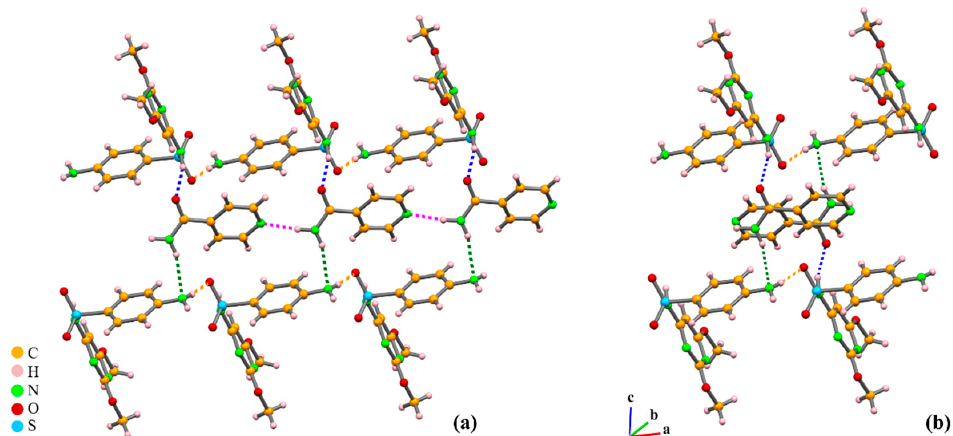
Figure 8. Crystal packing of SDM:ISO cocrystal: ( a ) in a view along the b-axis, with linear SDM chains interacting with two antiparallel ISO chains; ( b ) detail depicting the N − H terminal amine (SDM) ··· O sulfone (SDM) (yellow), N − H sulfonamide (SDM) ··· O(ISO) (blue), and N − H amide (ISO) ··· N terminal amine (SDM) (green) interactions [58].